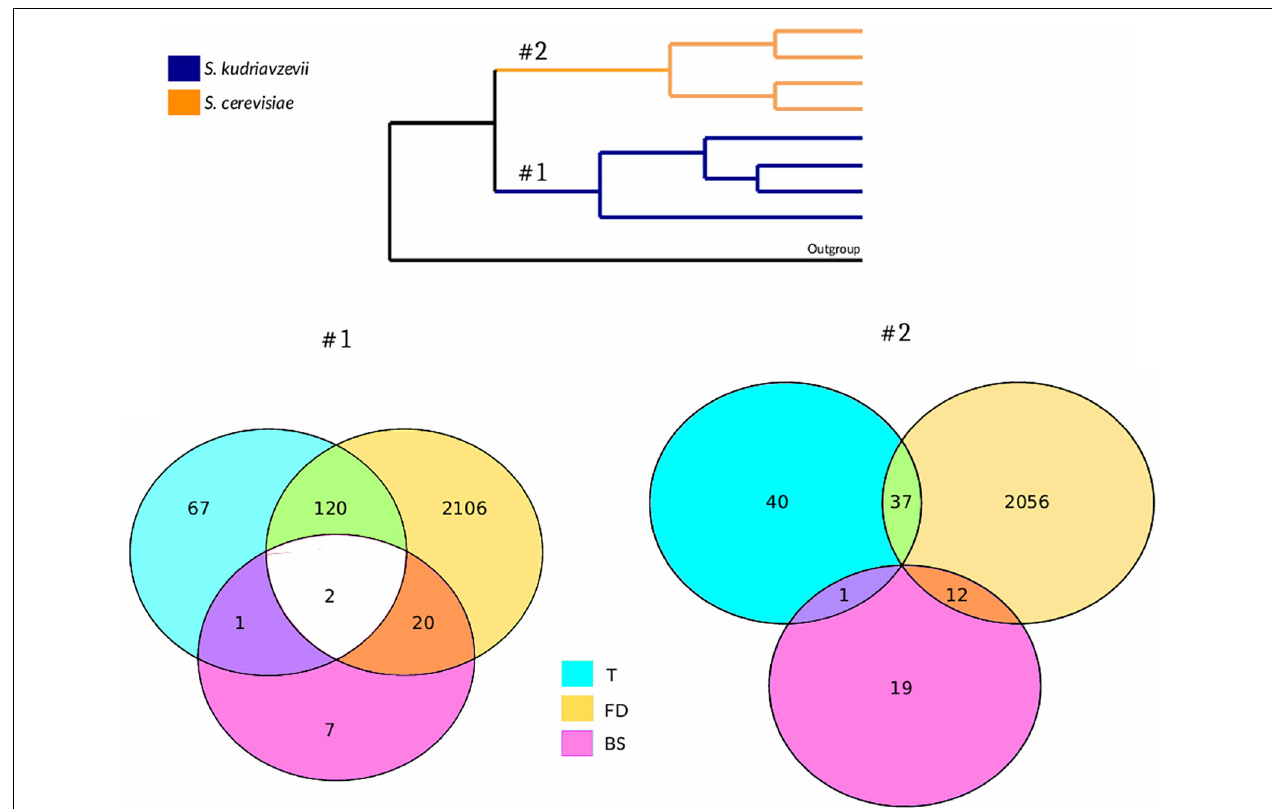
FIGURE 1 | Species-based comparative genomics approach. Venn diagrams represent the number of positive genes for every statistical test performed on both Sk (#1) and Sc (#2) branches of the tree to detect adaptive evolution. T, Tajima’s relative rate test; FD, functional divergence test; BS, branch-site model